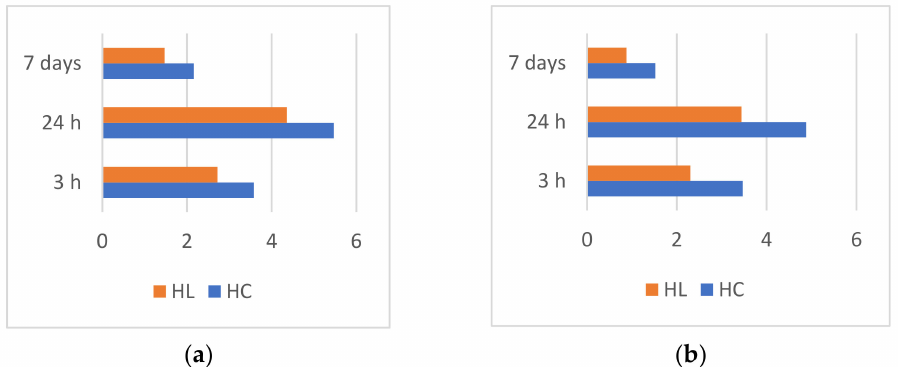
Figure 3. ( a ) VAS score value after applying the orthodontic device; ( b ) VAS score value after the first